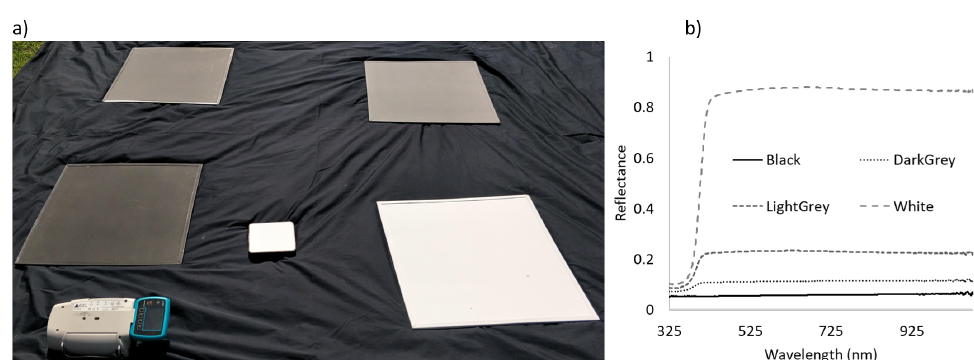
Figure 3. The four greyscaled spectral panels ( a ) were calibrated twice each season—before the start and after the end of the season. The reflectance curve ( b ) shows the sample reflectance of the four panels acquired using the ASD handheld spectroradiometer and the calibrated spectralon.